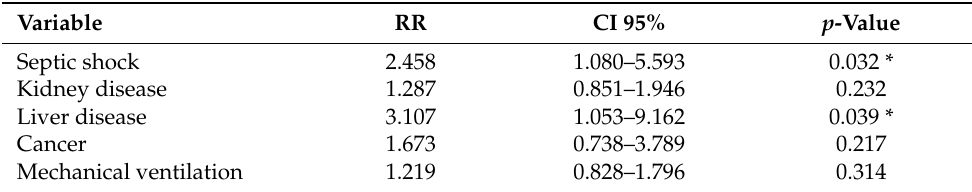
Table 5. Relative risk associated with mortality among adult ICU patients infected with multi-resistant P. aeruginosa